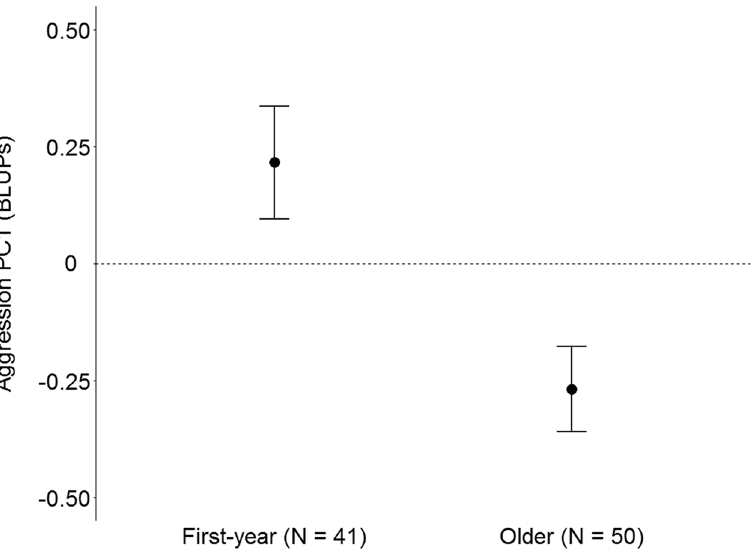
Figure 1. First-year females are more aggressive than older females, effect of age class on average aggression PC1 scores. Points indicate mean aggression PC1 scores (best linear unbiased predictors(BLUPs) from model with random intercepts for individual) and error bars indicate standard errors. Higher values indicate higher aggressiveness, and lower values indicate lower aggressiveness.